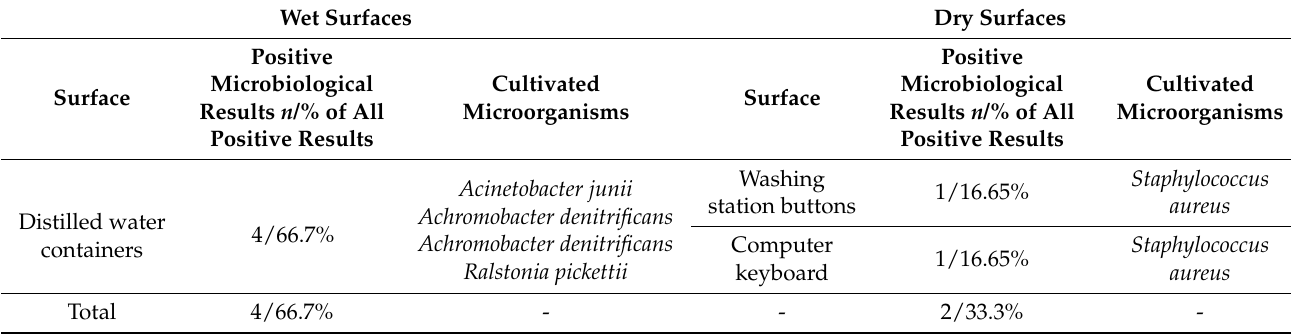
Table 2. Type of surfaces with the presence of potentially pathogenic